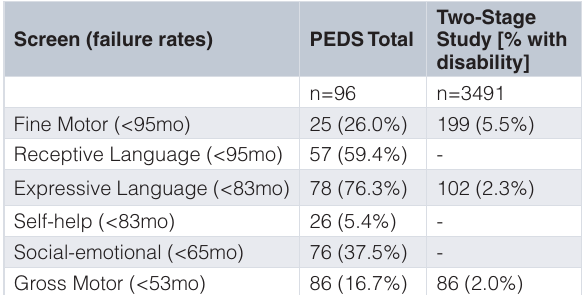
Table 4. Comparison of PEDS:DM results to Two-Stage Child Disability Study in Bhutan. Screen (failure rates) PEDS Total